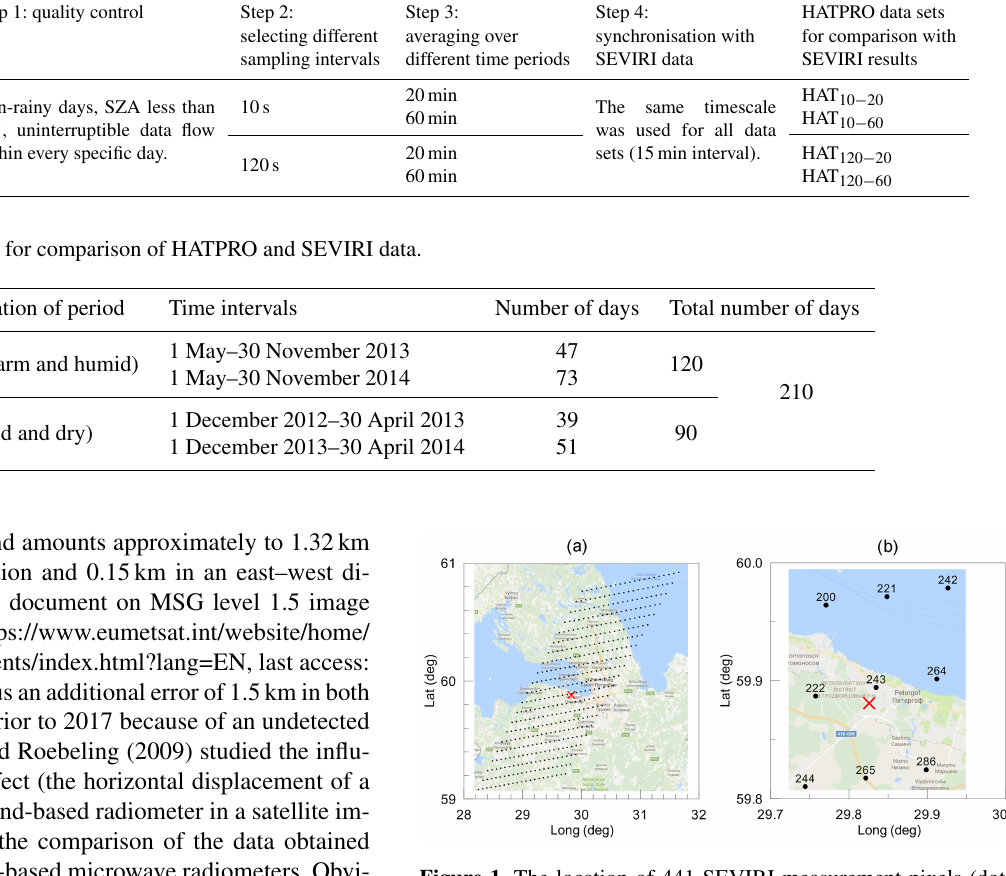
Table 1. The data selection steps and the designation of HATPRO data sets. Original data